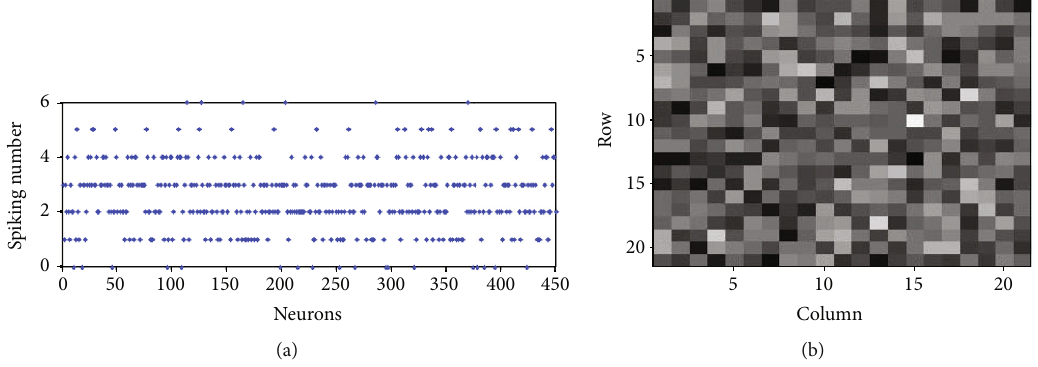
Figure 5: Firing rates of all excitatory neurons in E/I networks with noisy input to excitatory neurons, σ S excitatory neurons within 300ms; (b) visualization of the fi ring rates of neurons 1-400.